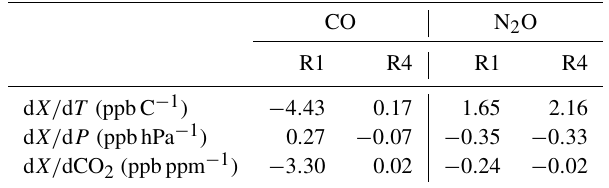
Table A2. MALT CO and N 2 O retrieval sensitivity to pressure (d X/ d P ) and temperature (d X/ d T ) measurement errors, in the two spectral regions R1 and R4. The CO and N 2 O retrieval sensitivity to CO 2 forward-model error (d X/ dCO 2 ) is also listed. These were derived in a theoretical MALT study using perturbed pressure (1, 10hPa), temperature (0.1, 1.0 ◦ C) and CO 2 (1, 10ppm) using a typical air